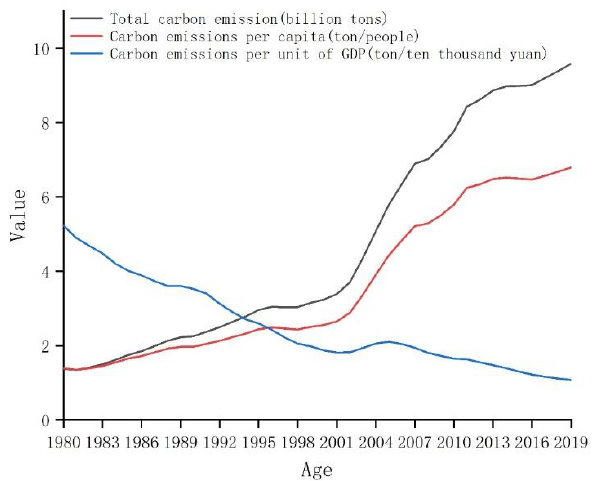
Figure 1. Total, per capita, and per unit GDP CO 2 emissions in China since 1980 (source: China Energy Statistical Yearbook, China Statistical Yearbook, and China Emission Accounts and Datasets).